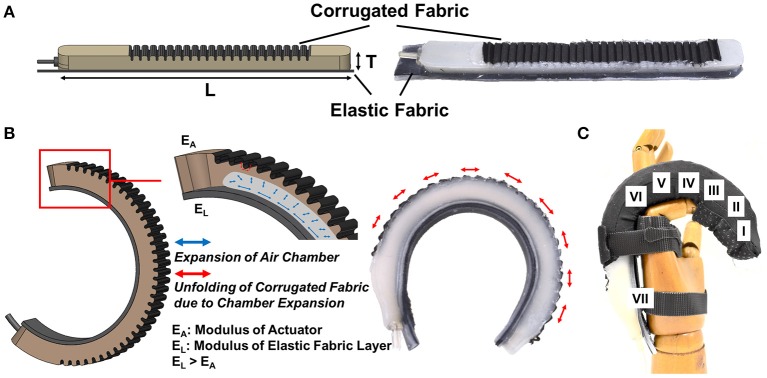
(A) A fabric-reinforced soft actuators with a corrugated fabric layer and an elastic fabric later [Actuator thickness, T = 12 mm, and length, L = 160 mm (Thumb), 170 mm (Little Finger), 180 mm (Index & Ring Fingers), 185 mm (Middle Finger)]. (B) Upon air pressurization, the corrugated fabric layer unfolds and expands due to the inflation of the embedded pneumatic chamber. Radial budging is constrained when the corrugated fabric layer unfolds fully. The elastic fabric elongates during air pressurization and stores elastic energy. The actuator achieves bending and extending motions at the same time. (C) A bending motion is preferred at the finger joints (II, IV, VI). An extending motion is preferred over the bending motion at the finger segments (I, III, V) and the opisthenar (VII).